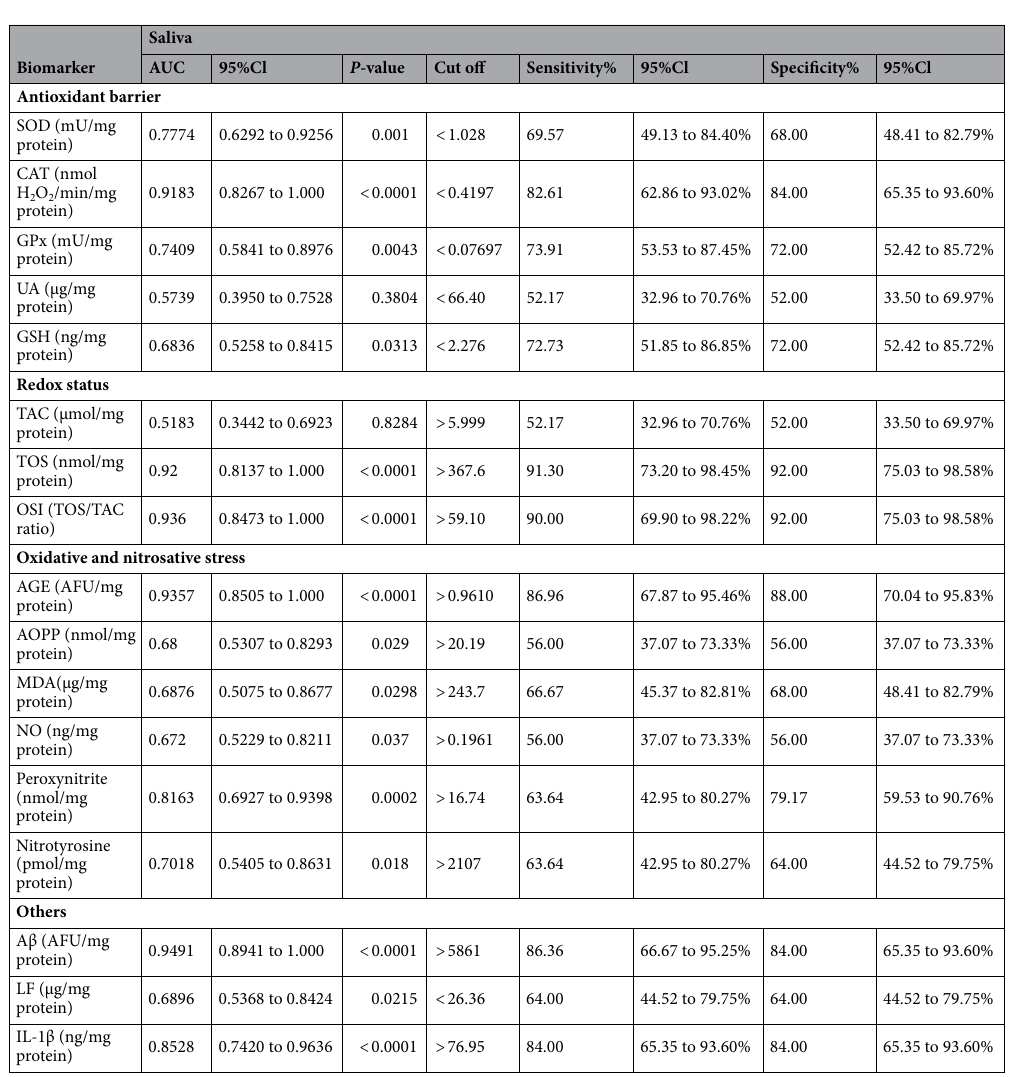
Table 4. Receiver operating characteristic (ROC) analysis of salivary redox biomarkers of patients with Alzheimer’s disease and the control group. AUC—area under curve; SOD—superoxide dismutase;